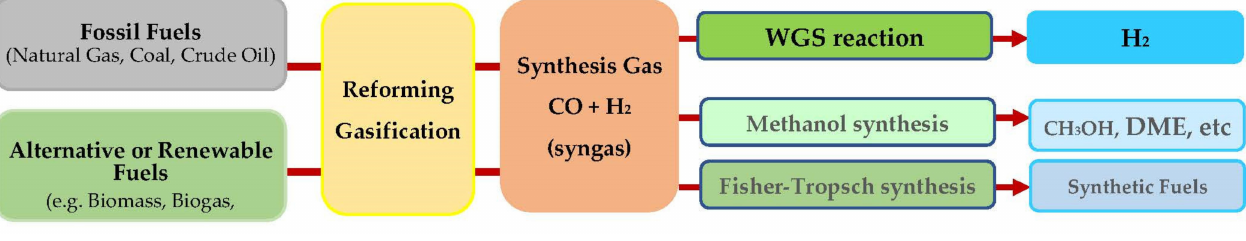
Figure 3. Syngas production and main applications. Table 2. Typical composition of syngas obtained by different processes and